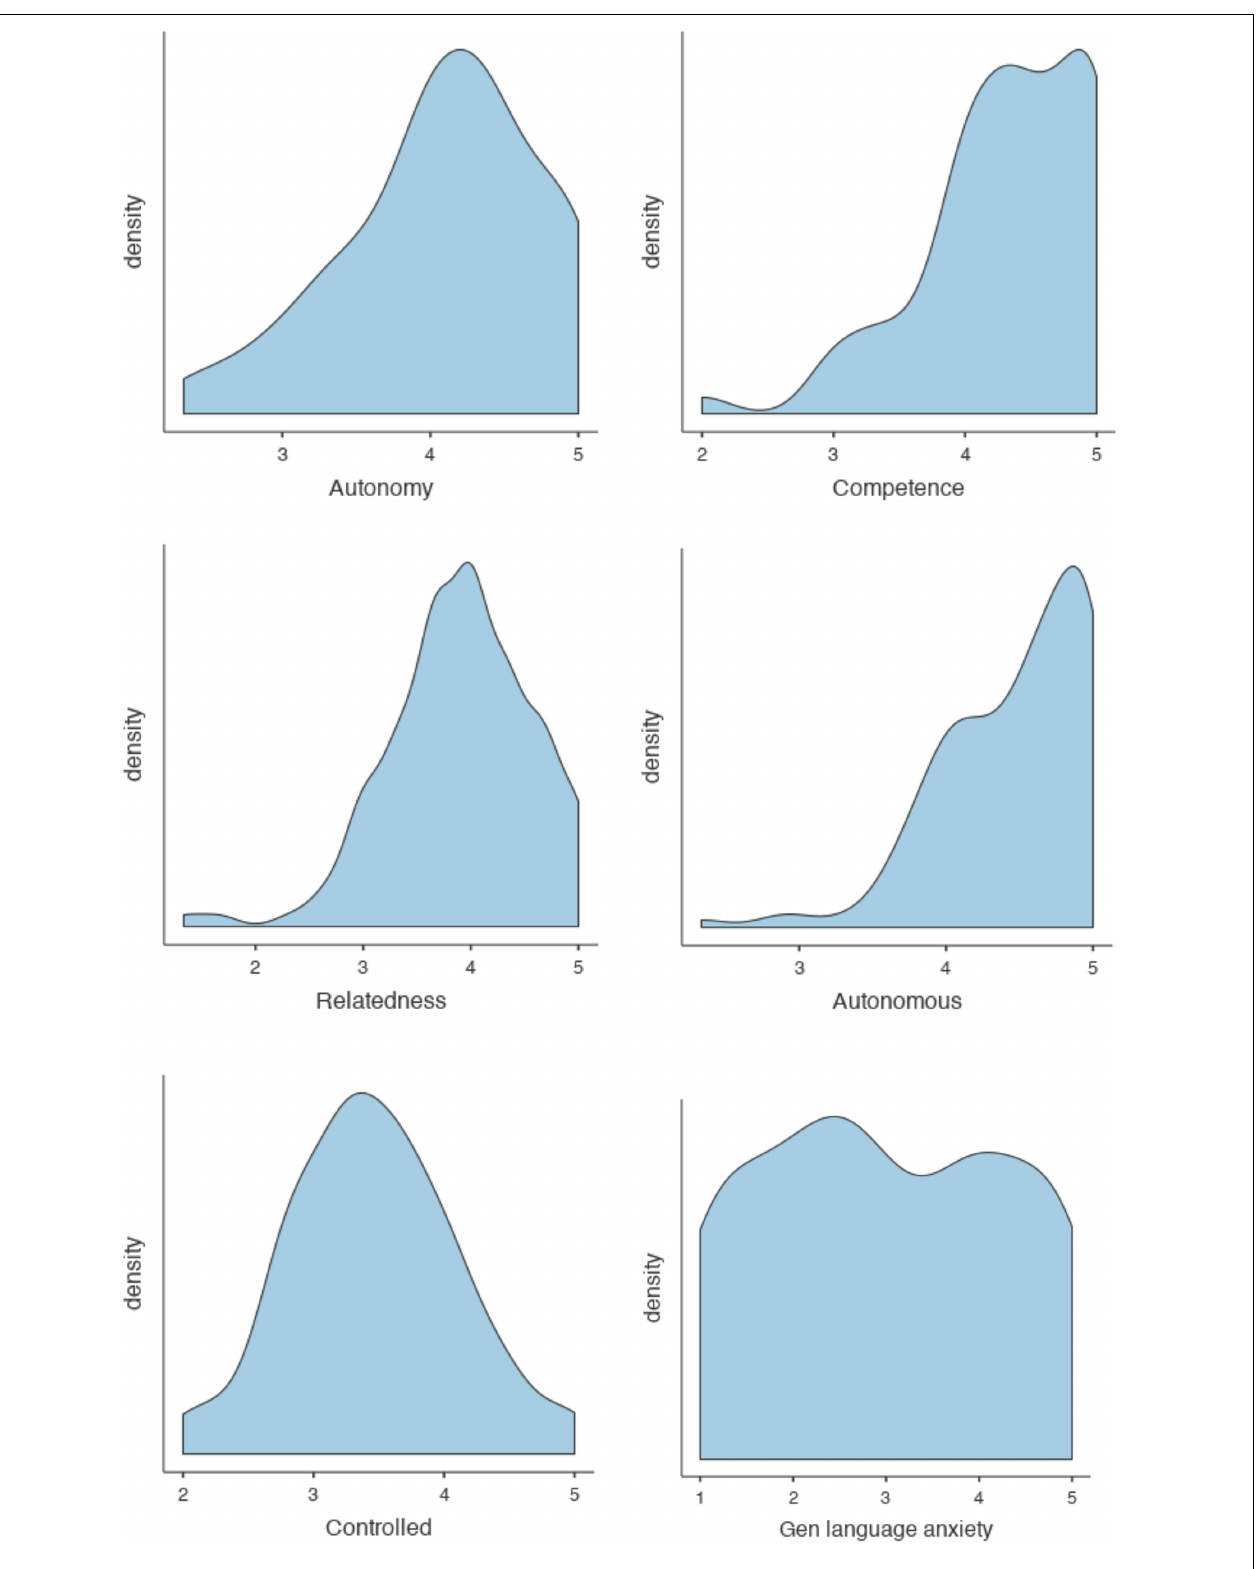
FIGURE 1 | Histogram density of study variables. Autonomous, autonomous motivation; controlled, controlled motivation; Gen language anxiety, general language anxiety.